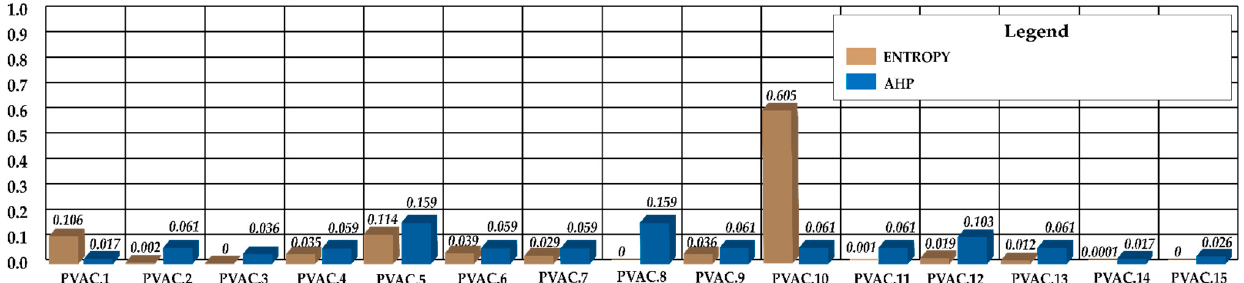
Figure 6. Importance of PVAC based on the two different MCDM methods.